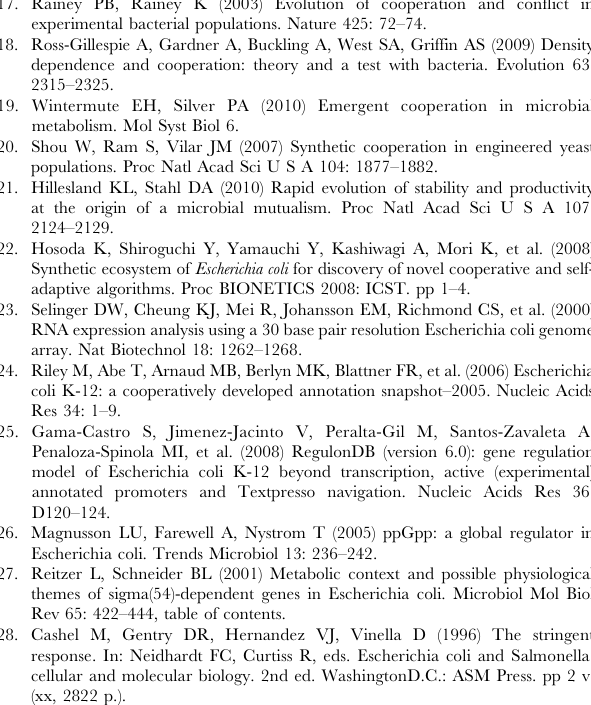
Figure S5 Measurement of the cell concentrations by flow cytometry (FCM). (A) The dot plot of the data collected from the coculture by FCM. I 2 cells (red dots), L 2 cells (green dots), and the calibration beads (yellow dots) were clearly segregated. The definitions of these three particles were as follows: x . 1.6 (red dashed line), y . 15 (red dotted line), and Log 10 y . Log 10 x + 0.43 (red solid line) for I 2 cells, where x and y represent green and red florescent intensities (a. u.), respectively; x . 15 (green dashed line) and y , 0.036 x + 10 (green solid line) for L 2 cells; x . 540 (yellow dashed line), y . 0.036 x + 10 (green solid line), and Log 10 y , 0.256